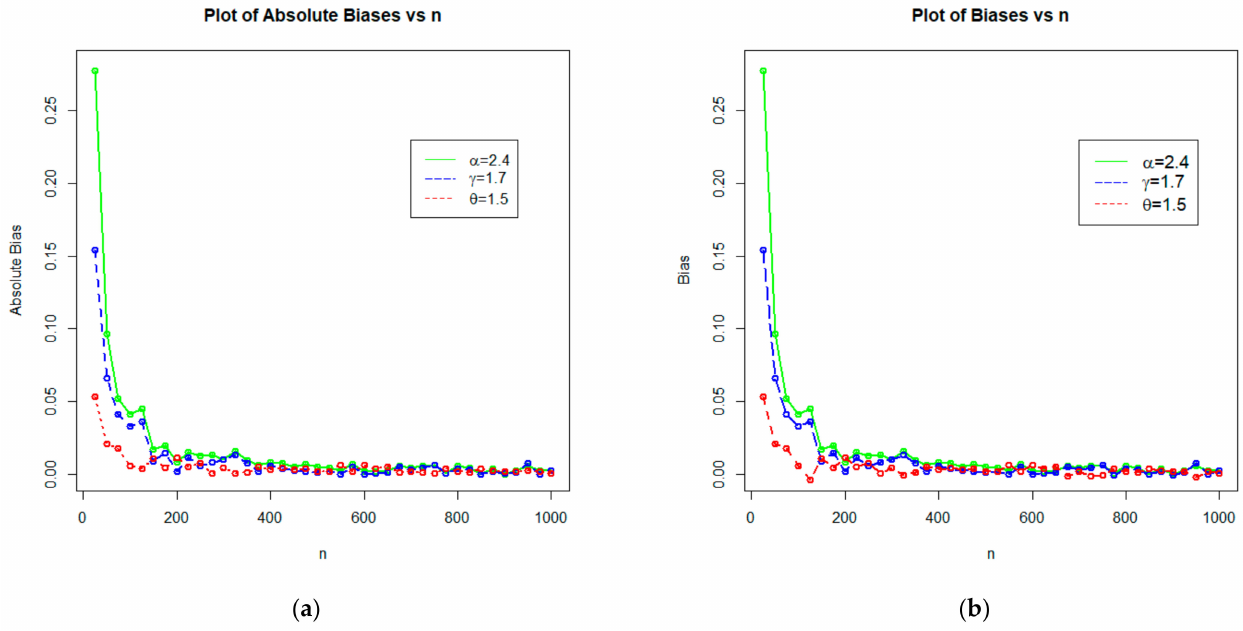
Figure 8. Plots of ( a ) absolute biases vs. n, and ( b ) biases vs. for Set 2: α = 2.4, γ = 1.0, θ =